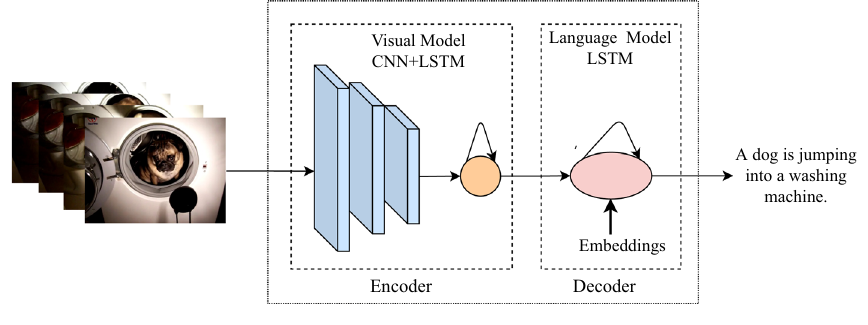
Fig. 1 The overview video captioning